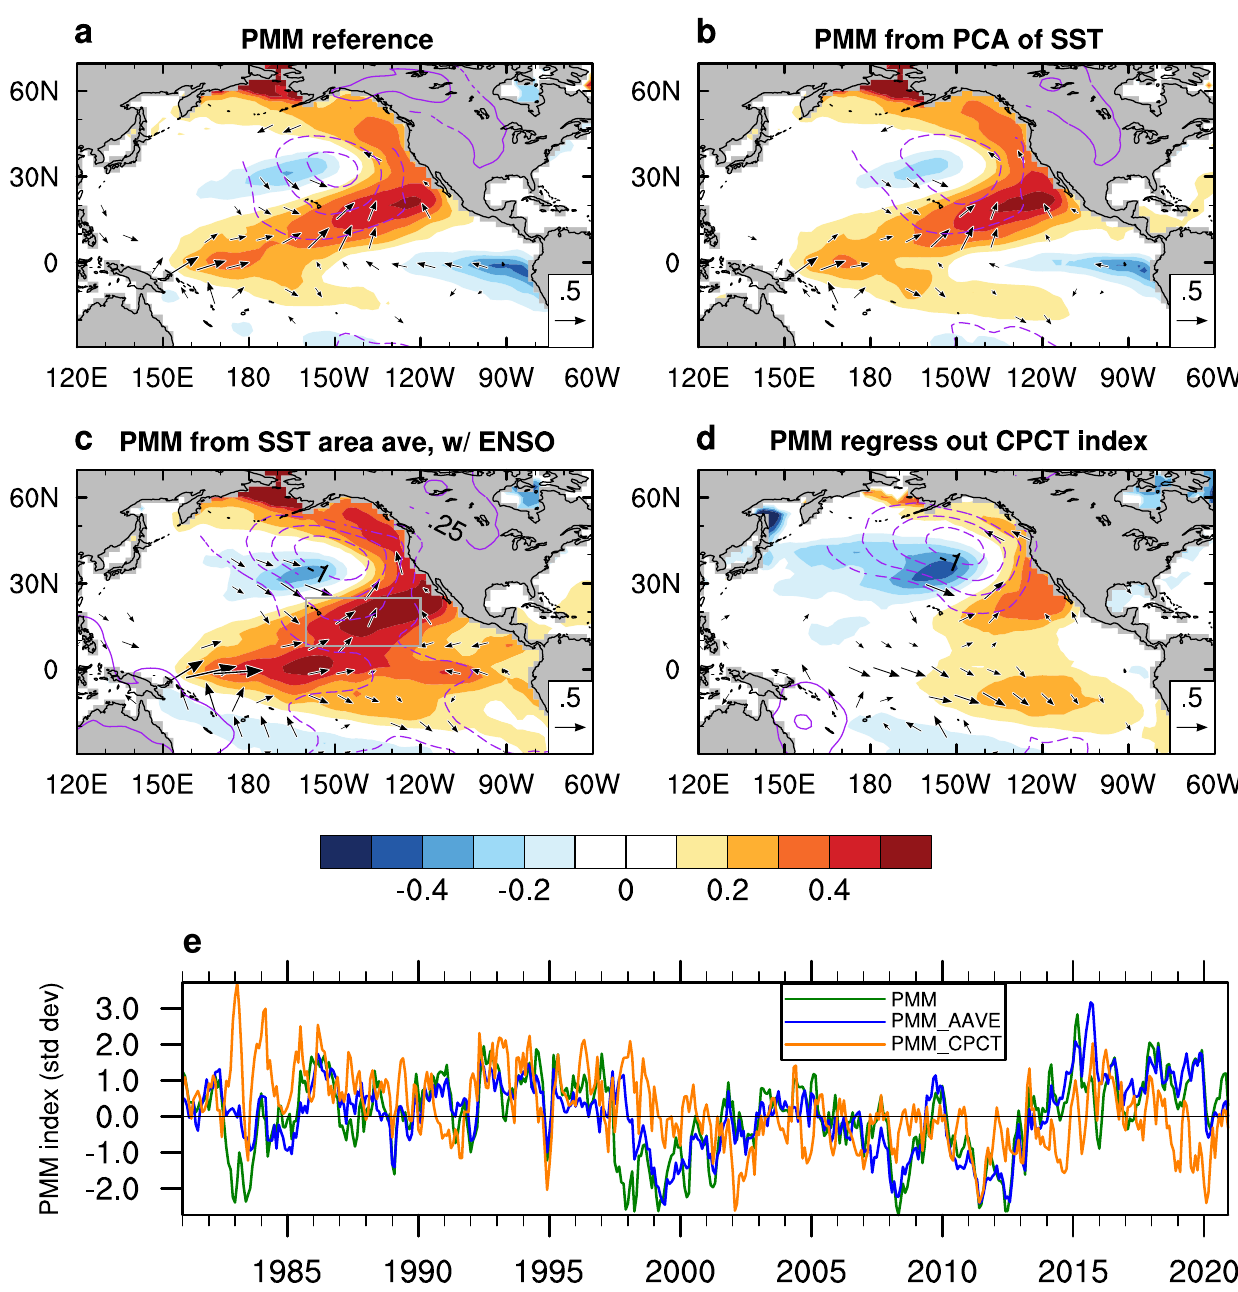
Fig. 1 The reference PMM-T and alternative indices. a Regression of the Paci fi c Meridional Mode (PMM) index (derived via MCA) onto anomalies of SST (°C, shading), surface winds (m s − 1 , vectors), and sea-level pressure (contours, interval of 0.25 hPa). Negative contour lines are dashed and the 0-contour line is omitted. Only values signi fi cant at the 95% con fi dence level are shown. b Similar to ( a ), but for the expansion coef fi cient of a principal component analysis of SST (PMM_EOF). c Similar to ( a ), but for an index that is simply the area average of SST anomalies in the gray box, and without removing ENSO variability beforehand. d Like ( a ), but using a more thorough way of removing ENSO variability (see text). e Time series of three of the indices in ( a ), ( c ), and ( d ), normalized by their respective standard deviations. The time series of ( b ) is not shown as it is very similar to that of ( a ). All fi elds are from the NCEP/NCAR processes that underlie the PMM and its equatorward propaga- Caveats regarding the use of MCA for identifying coupled wind-SST variability in the subtropical North Paci fi c tion. Statistical analysis of SST alone, however, yields a pattern that is very similar (Fig. 1b; based on principal component analysis The PMM is thought to rely on the WES feedback, which is distinct (PCA) as described in “ Methods ” ) to the one derived by MCA from the Bjerknes feedback 24 which governs equatorial Paci fi c (Fig. 1a). The patterns of SST, wind, and sea-level pressure (SLP) are variability and ENSO. By considering the coupled variability of SST and surface winds, the MCA aims to diagnose the coupled correlated with the original PMM patterns at 0.97 to 0.98, while the